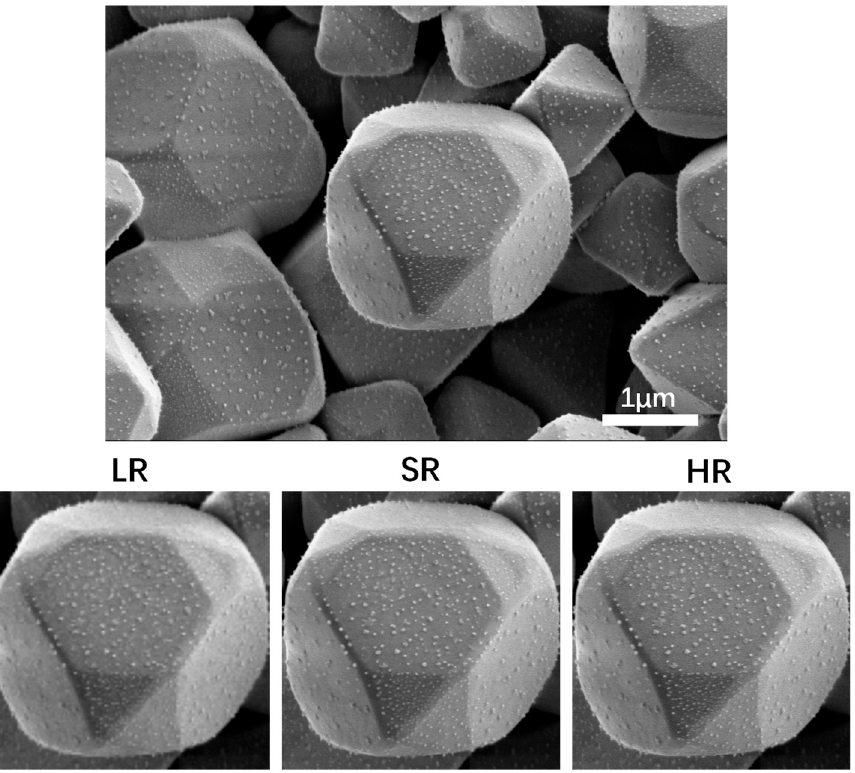
Figure 4. Test example of AgCl@Ag SEM image. The original SEM image with the cropped LR compared to the SR and HR versions.